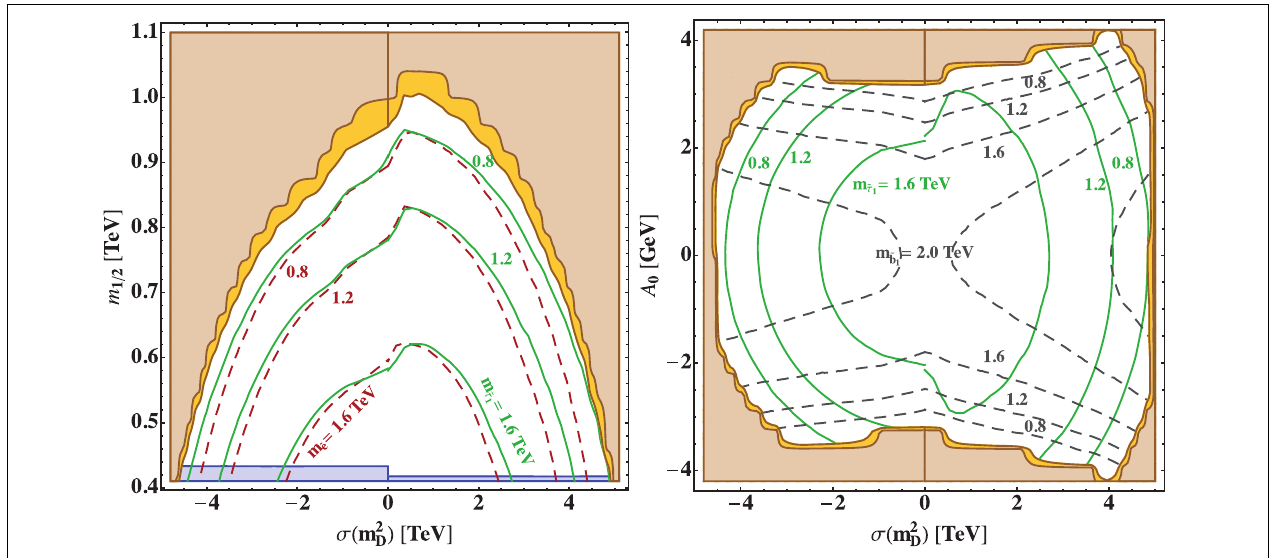
FIGURE 8 | As Figure 6, but with the remaining model parameters fixed as described in Equation (24).